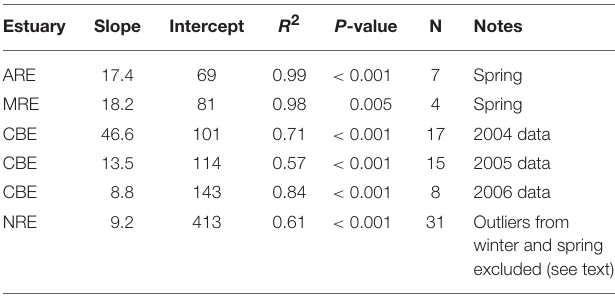
TABLE 2 | Linear regression results between lignin concentration ( 6 8 ) and DOC concentration for four estuaries in this study. Estuary